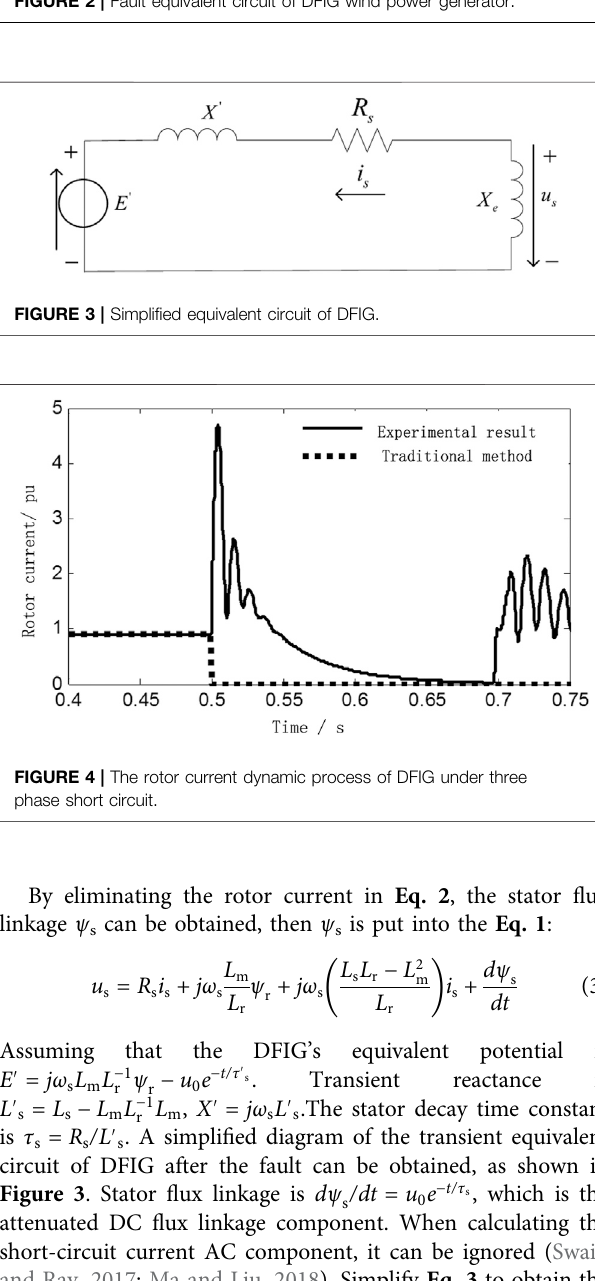
Figure 3 . Stator fl ux linkage is d ψ attenuated DC fl ux linkage component. When calculating the short-circuit current AC component, it can be ignored (Swain and Ray, 2017; Ma and Liu, 2018). Simplify Eq. 3 to obtain the relationship among the short-circuit current, transient reactance